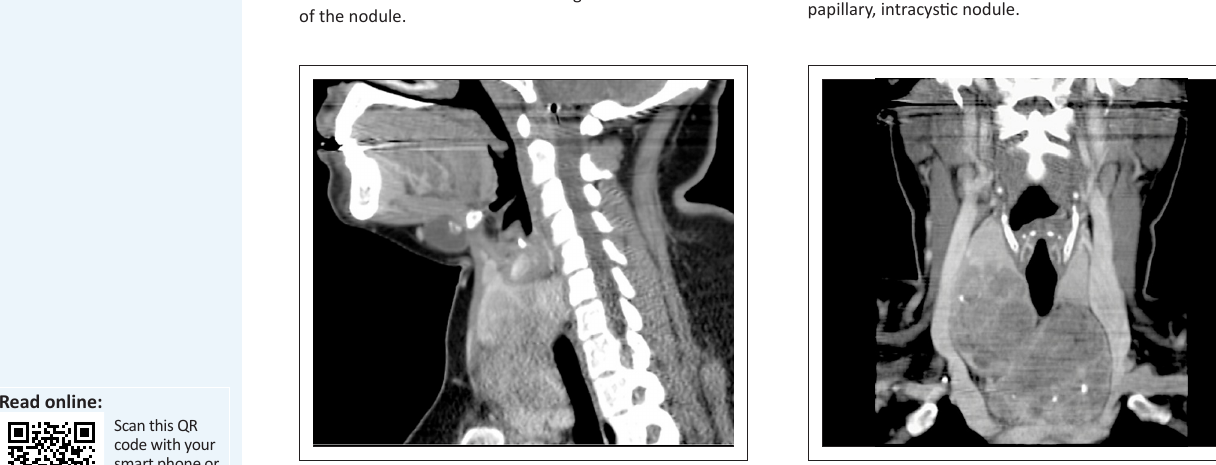
FIGURE 3: Sagittal paramidline computerised tomography (CT) image of the neck showing the relation of the thyroglossal duct cyst (TDC) to the hyoid bone.